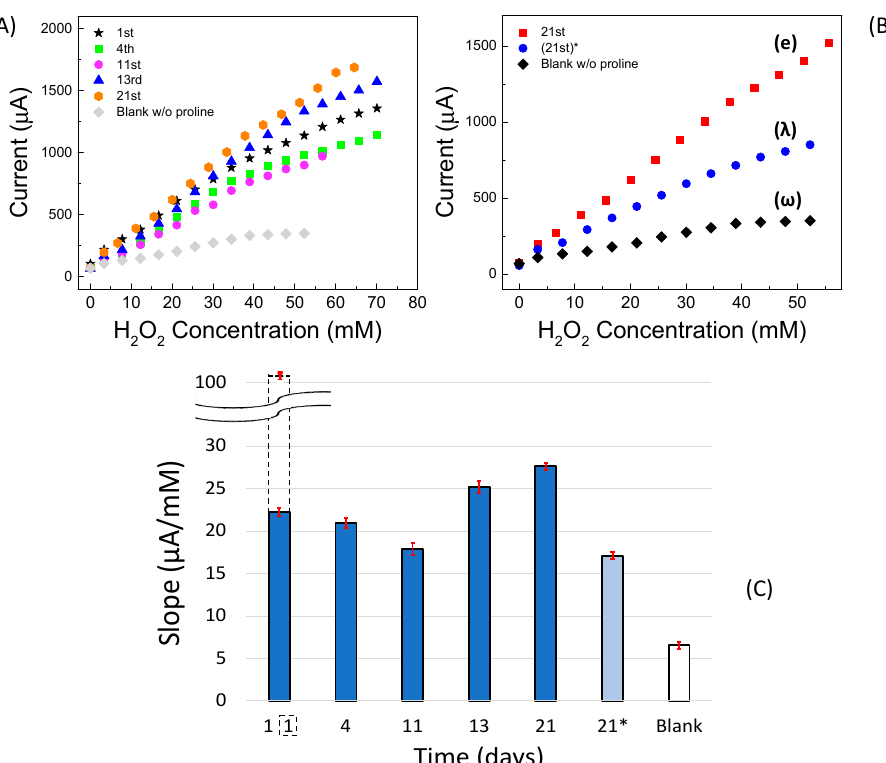
Figure 4. Non-enzymatic catalytic (GC-Ag paste )-proline-assisted LDH amperometric sensor. ( A ) Cal- ibration curves as a function of lifetime including the “blank” curve recorded on the first day. ( B ) Comparison among calibration curves obtained on the (e) 21st day, ( λ ) 21st day without proline addition in solution, using the same sensor, and ( ω ) blank, recorded on the first day. Each point is the mean of at least three determinations. ( C ) Bar chart of straight-line slopes as a function of life- time. Dotted bar indicates the slope of the calibration curve recorded on the first day under nitrogen stream, whereas 21* (i.e., the slope of λ curve) is that on the 21st day without new addition proline in solution.